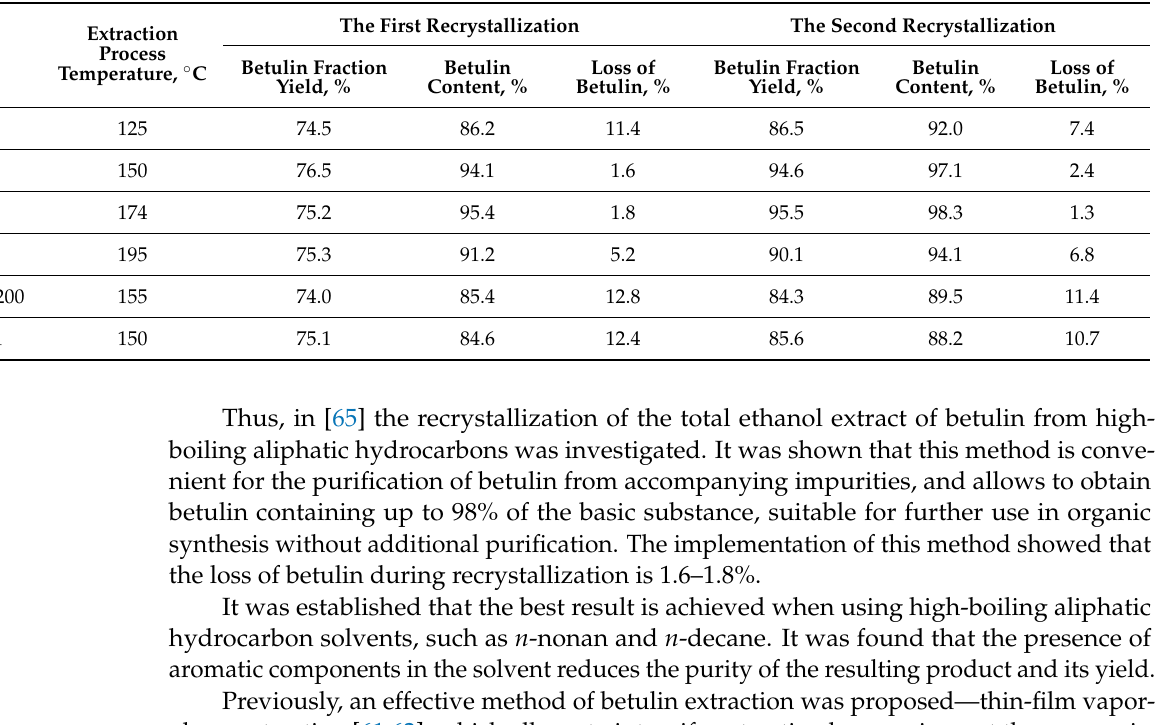
Table 4. Characteristics of the obtained betulin